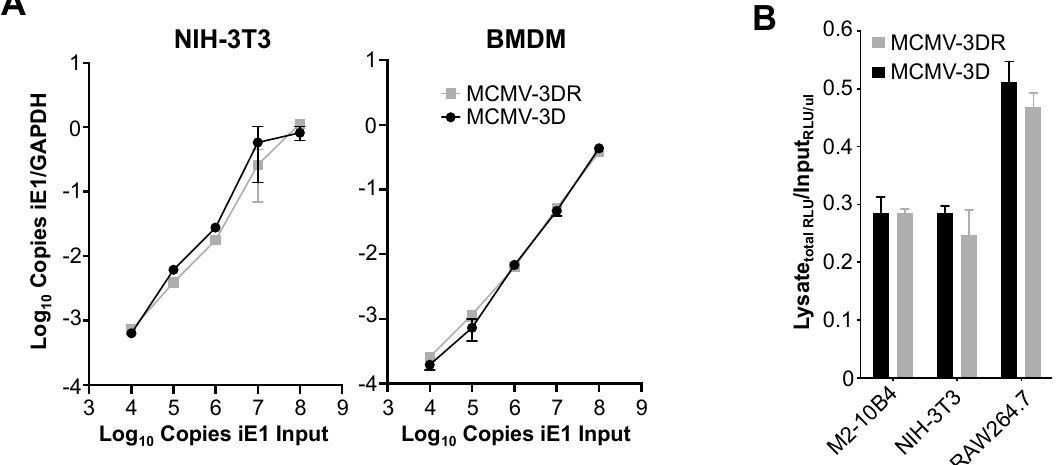
Figure 3. MCK-2 is dispensable for MCMV binding to the surface of fibroblasts and macrophages. ( A ) Molecular analysis. The cell types indicated above each graph were incubated on ice with increasing copy numbers (10 4 –10 8 ) of the MCMV viruses indicated by the inset in the right panel. Virus copy numbers were quantitated as the number of viral iE1 gene copies (input) in the corresponding viral stocks. After extensive PBS washing to remove unbound virus, total DNA was isolated and the total copies of cellular Gapdh and viral iE1 were determined by qPCR. Data are presented as the mean ± SD of triplicate determinations of the ratio of (copies iE1)/(copies Gapdh) from one experiment and are representative of three independent experiments. ( B ) Infectivity analysis. The cell lines indicated on the x-axis were incubated at an moi = 0.5 on ice with the Gaussia luciferase reporter viruses MCMV-3D (black bars) or MCMV-3DR (gray bars). After several PBS washes to remove unbound virus, cells were collected and lysed by three freeze-thaw cycles. Fresh M2-10B4 cells were infected with viral inputs or cell lysates and 18 hpi the relative luminescence units (RLUs) in 10 μ L of supernatant was determined. Data are quantitated as the total RLUs obtained after infection with the cellular lysates relative to the RLUs obtained per μ l of viral input used to infect M2-10B4 cells. Data are presented as the mean ± SD of triplicate determinations from one experiment and are representative of three independent experiments. M2-10B4 and NIH-3T3 are mouse fibroblast cell lines; RAW264.7 is a mouse macrophage cell line.